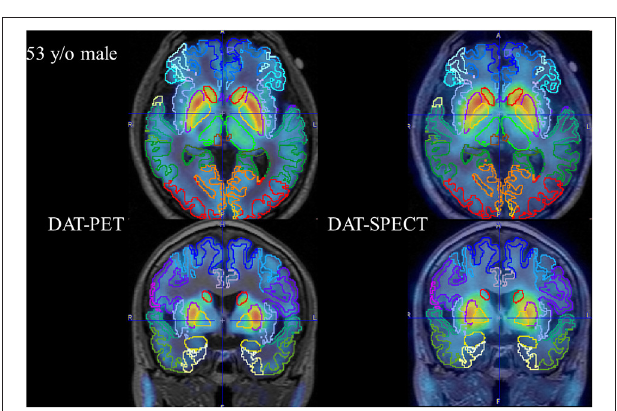
FIGURE 2 | Representative case (53-year-old male). Axial and coronal fused PET (left column) and fused SPECT (right column) are shown.